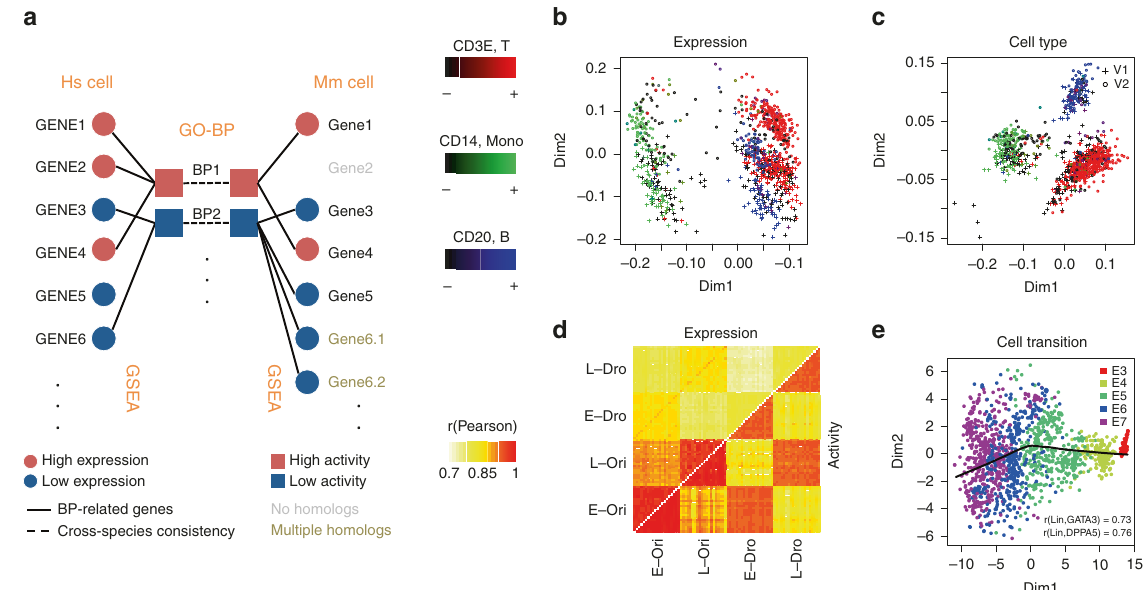
Fig. 1 Overview of BPA and performance on single-cell data sets. a Overview of biological process activity inference. Single = cell gene expression pro fi les for human (outer left column) can be compared with a mouse gene expression pro fi le (outer right column) using transformed biological process activity pro fi les for human (inner left) and mouse (inner right) even though the gene members of each Gene Ontology Biological Process (GO-BP) are distinct in each species (outer links). b Single peripheral blood mononuclear cells (PBMCs) pro fi led using 10x Genomics V1 and V2 chemistry were visualized using transcript expression features. Cells were color-coded according to expression of B-cell, monocyte and T-cell-speci fi c markers CD3E, CD14, and CD20, respectively. Two clusters for each cell type, corresponding to each of the Chromium chemistries are visible before the BPA transform. c Same as part B but PBMC data plotted after applying the BPA transform resulting in one cluster per cell type and no visible chemistry batch effect. d Drop-out events (Dro) were simulated into GTEx lung (L), and esophagus (E) bulk RNA-sequencing (Ori) data (Supplementary Fig. 2, see Methods); pairwise correlations between samples was computed and plotted, resulting from comparisons using the original gene expression features (upper matrix triangle) and using BPA features (lower matrix triangle); high correlations, red; low correlations, yellow. BPA preserves same tissue comparisons even for drop-outs and has lower on average cross-tissue correlation than using gene expression features. e BPA transform preserves the developmental order of embryo development of the original study 13 based on the pseudotime inferred from principal curve 14 construction in t-SNE space 15 (Supplementary Fig.